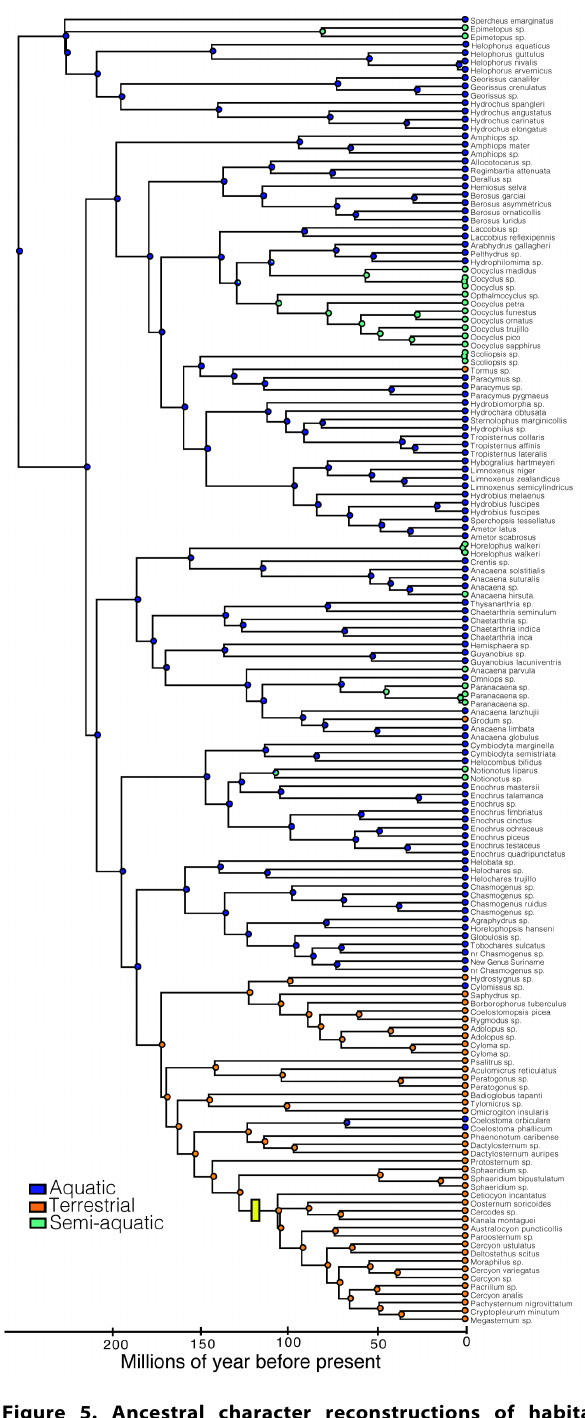
Figure 5. Ancestral character reconstructions of habitat transitions on the time-calibrated phylogeny of Hydrophilidae. The pie charts at nodes indicate maximum likelihood support for ancestral states. A yellow bar indicates the location of the diversification rate shift determined by MEDUSA. doi:10.1371/journal.pone.0098430.g005 the pull of the present). However, the selection of a (Yule) pure- birth model suggests extinction rates may not be the driving factor, and that the increase in net diversification is due to increased speciation rates.